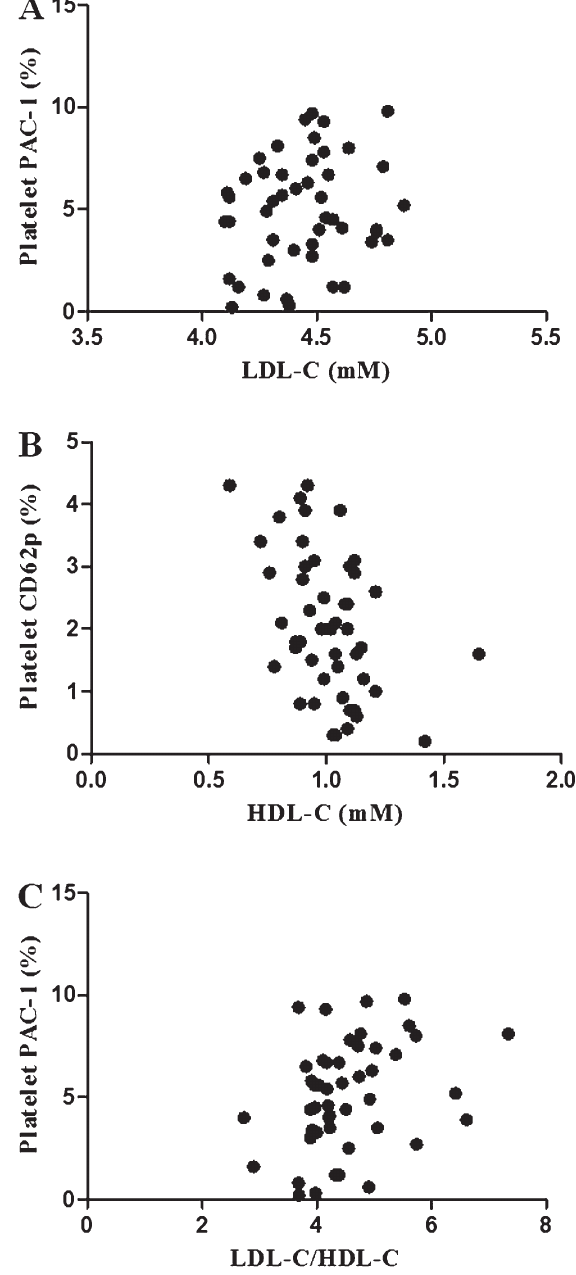
Figure 2. Correlation analysis among the patients with high levels of LDL-C. A , Correlation between LDL-C and platelet PAC-1 (P . 0.05). B , Correlation between HDL-C and platelet CD62p (P , 0.05). C , Correlation between LDL-C/HDL-C and platelet PAC-1 (P , 0.05). LDL-C: low-density lipoprotein cholesterol; HDL-C: high-density lipoprotein